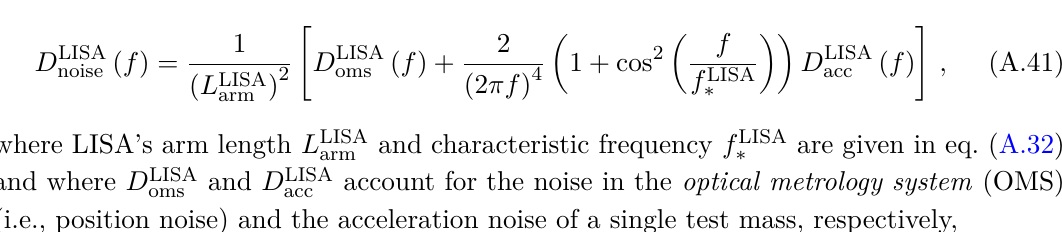
Table 4 . Documents on dcc.ligo.org that allow one to download the numerical data for the detector noise spectra of aLIGO, aVirgo, KAGRA, and CE according to their design and O2 sensitivities.